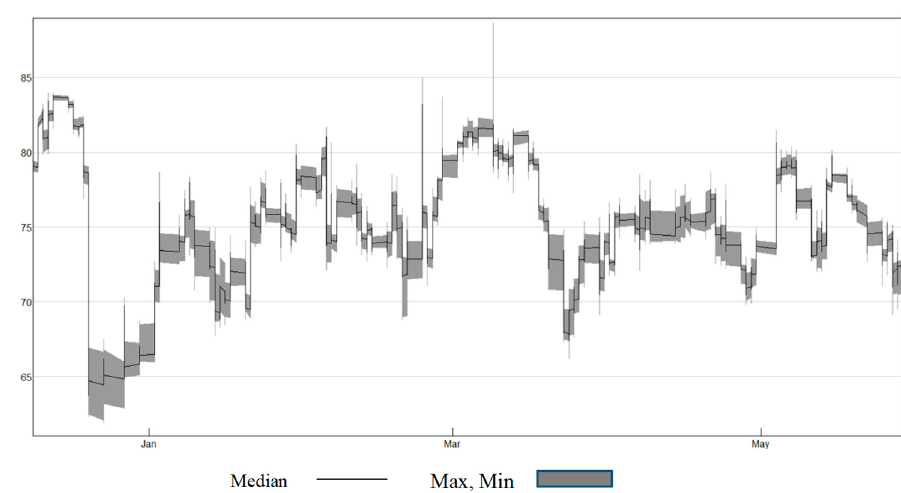
Figure A2. Sensitivity of the index to the VAR lag (2–6) structure.